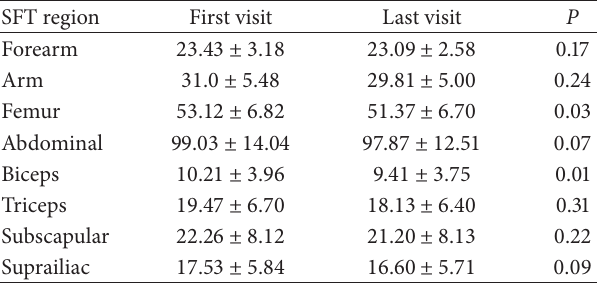
Table 4: Comparison of the initial regional skinfold thickness (SFT) with the end of the study in hypothyroid